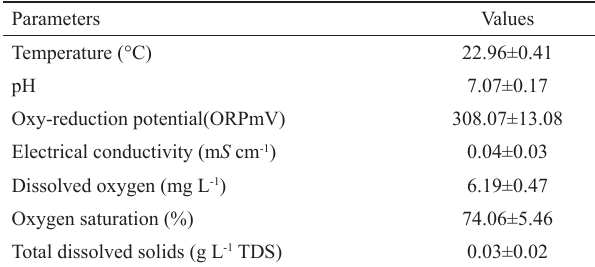
Table 1. Measured parameters of the quality of the water used in the fertilization of oocytes and incubation of the Steindachneridion parahybae